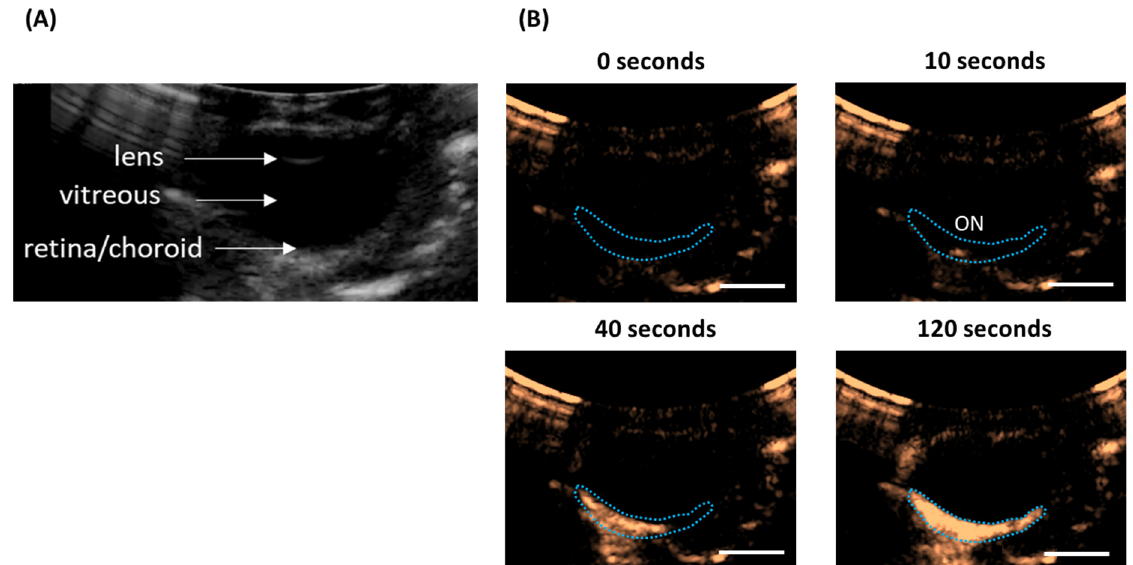
Figure 1. ( A ) Experimental setup used in USMB experiments. ( B ) Image of a porcine eye. Yellow rectangle indicates the orientation of the C5-1 probe during ultrasound imaging and USMB treat- ment.